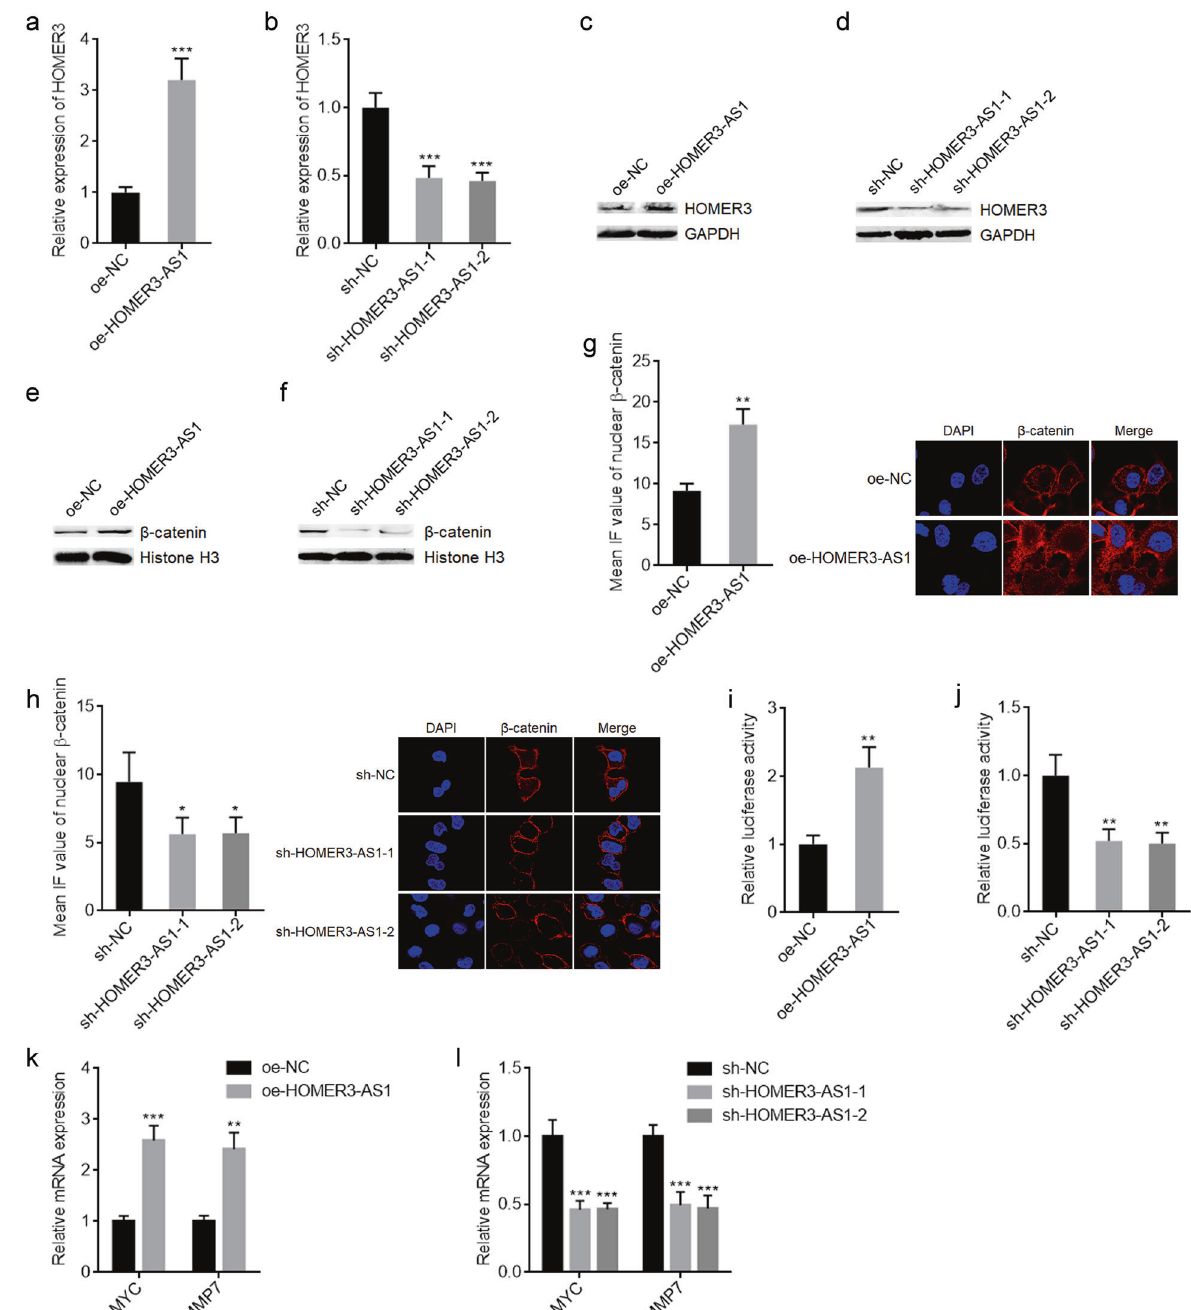
Fig. 4 HOMER3-AS1 increased HOMER3 expression and activated Wnt/ β -catenin signaling. a HOMER3 mRNA levels in SK-HEP-1 cells with HOMER3-AS1 stable overexpression or control was measured by qRT-PCR. b HOMER3 mRNA levels in SK-HEP-1 cells with HOMER3-AS1 stable silencing or control were measured by qRT-PCR. c HOMER3 protein levels in SK-HEP-1 cells with HOMER3-AS1 stable overexpression or control was measured by western blot. d HOMER3 protein levels in SK-HEP-1 cells with HOMER3-AS1 stable silencing or control was measured by qRT- PCR. e Nuclear β -catenin protein levels in SK-HEP-1 cells with HOMER3-AS1 stable overexpression or control was measured by western blot. f Nuclear β -catenin protein levels in SK-HEP-1 cells with HOMER3-AS1 stable silencing or control was measured by western blot. g β -catenin expression in the nucleus of SK-HEP-1 cells with HOMER3-AS1 stable overexpression or control was detected by IF. h β -catenin expression in the nucleus of SK-HEP-1 cells with HOMER3-AS1 stable silencing or control was detected by IF. i β -catenin reporter TOPFlash and pRL-TK which encodes Renilla luciferase were transfected into SK-HEP-1 cells with HOMER3-AS1 stable overexpression or control. Dual-luciferase reporter assays were undertaken to determine β -catenin transcriptional activity. j β -catenin reporter TOPFlash and pRL-TK were transfected into SK- HEP-1 cells with HOMER3-AS1 stable silencing or control. Dual-luciferase reporter assays were undertaken to determine β -catenin transcriptional activity. k Wnt/ β -catenin downstream targets MYC and MMP7 expressions in SK-HEP-1 cells with HOMER3-AS1 stable overexpression or control. l Wnt/ β -catenin downstream targets MYC and MMP7 expressions in SK-HEP-1 cells with HOMER3-AS1 stable silencing or control. Results are presented as mean ± SD based on three independent experiments. * p < 0.05, ** p < 0.01, *** p < 0.001 by Student ’ s t -test ( a , g , i , k ) or one-way ANOVA followed by Dunnett ’ s multiple comparisons test ( b , h , j , l